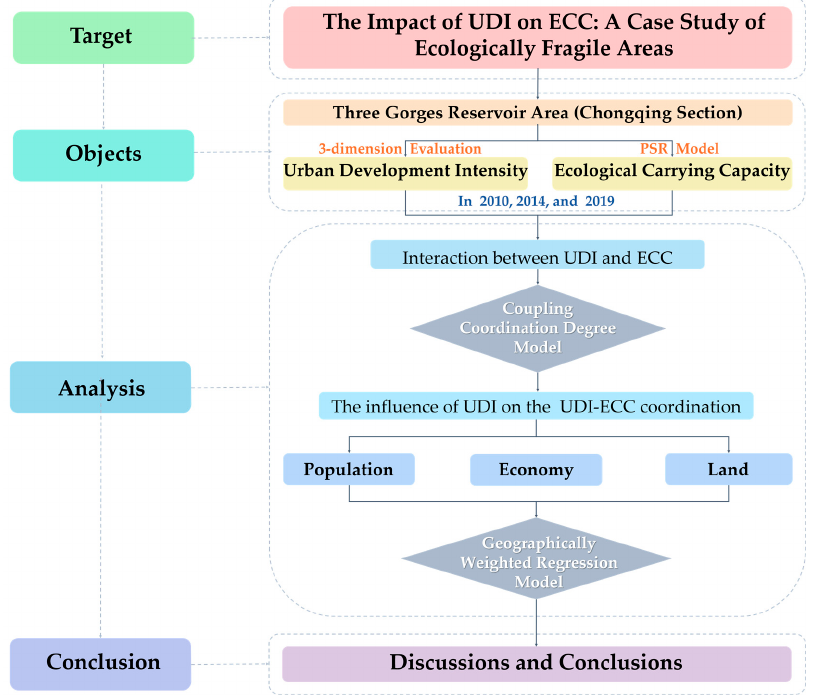
Figure 3. Research framework. Sources: Established by the authors.